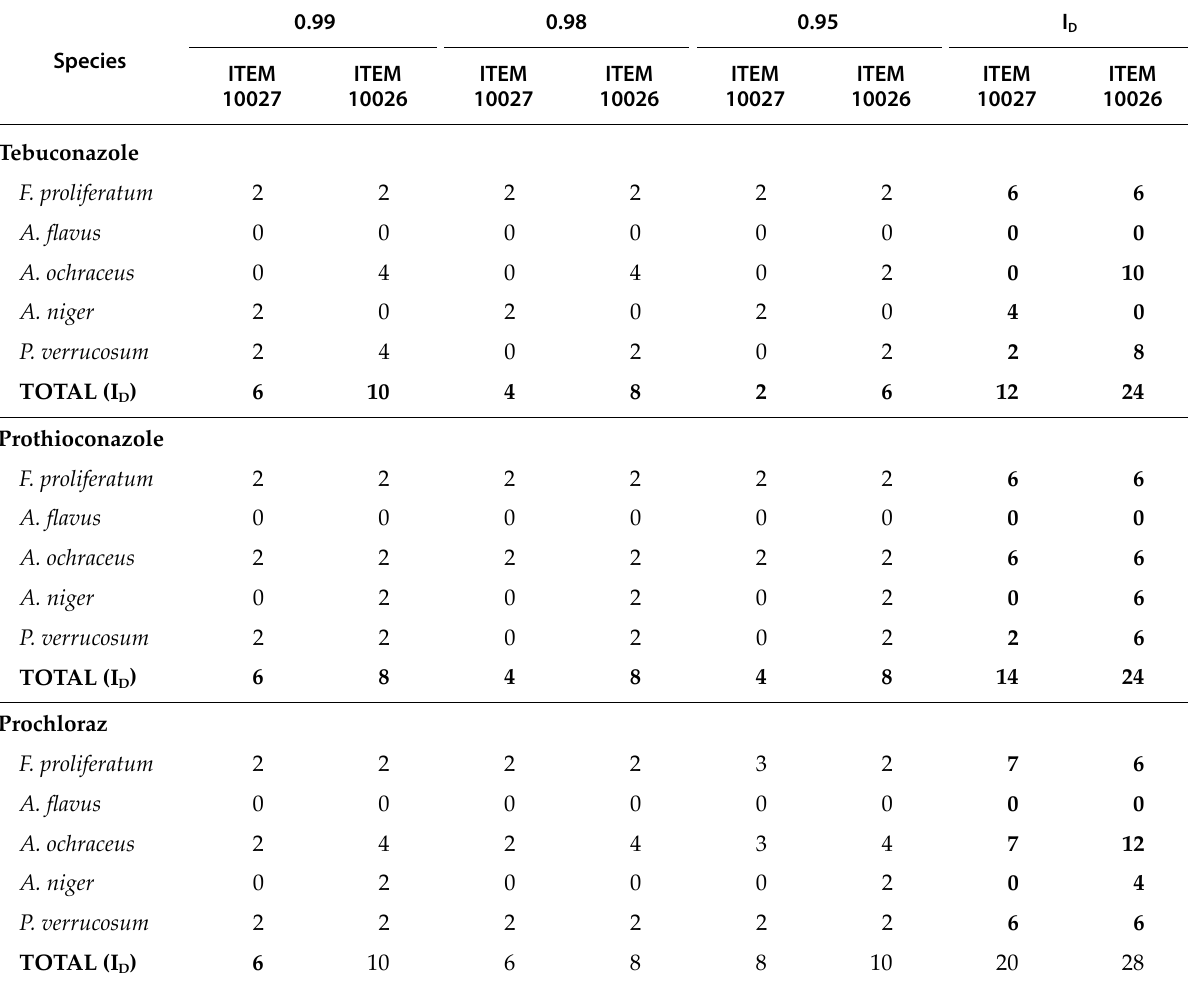
Table 7. Interactions between Fusarium verticillioides (ITEM 10027) and other common maize grain fungi, on maize agar at various a w levels and amended with tebuconazole, prochloraz or prothioconazole. Plates were incubated at 25°C for 14 d.